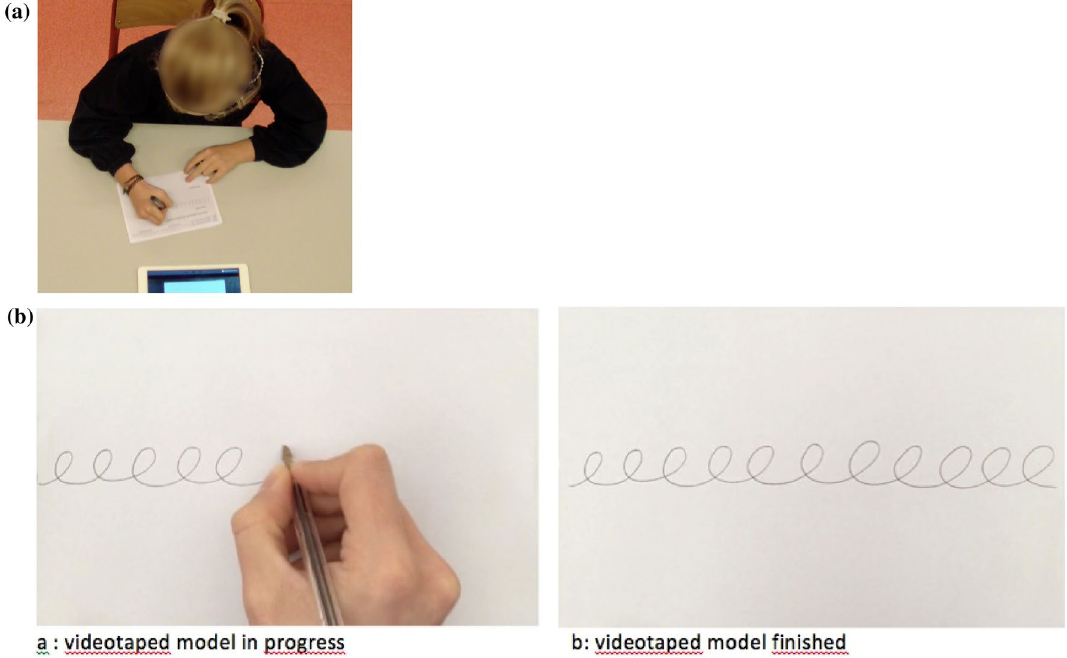
Figure 3. ( a ) Setting with a child (5th grade) when drawing a line of cycloid loops with a digital pen on a paper sheet put on the table. ( b ) Extracted from the videotaped model presented to the child on the iPad tablet for the model of the copy of a line of cycloid